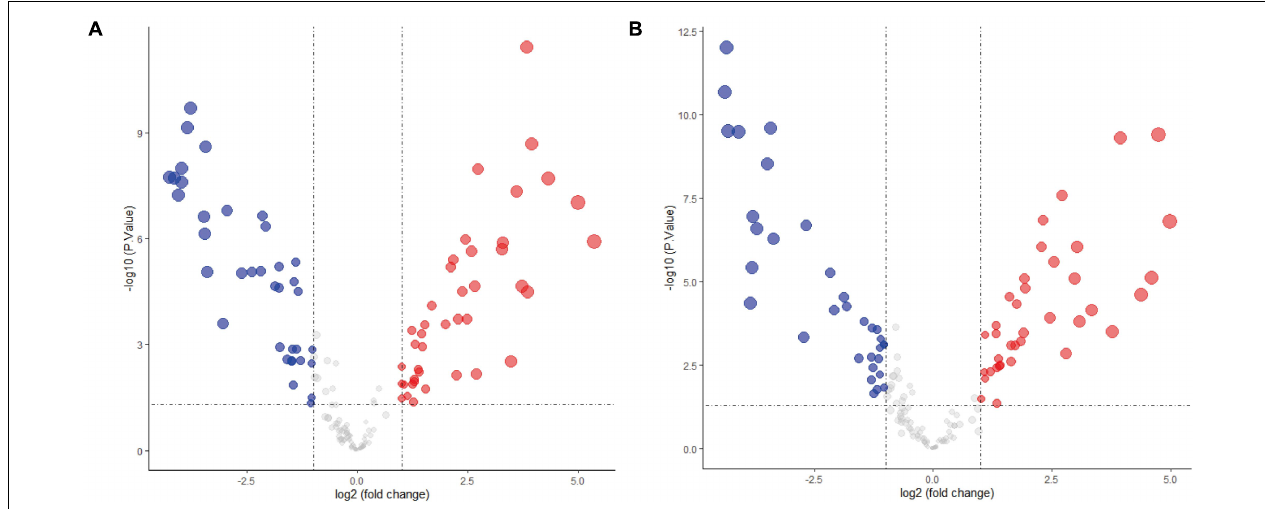
FIGURE 1 | Differentially expressed microRNAs analysis of the GSE153089 dataset. (A) DE-miRNAs between fetal-type tumor and normal liver samples were visualized via volcano plot. (B) DE-miRNAs between embryonal-type tumor and normal liver samples were visualized via volcano plot. Red points representing up-regulation; blue points indicating down-regulation; gray points representing normal expression. DE-miRNAs, differentially expressed microRNAs.